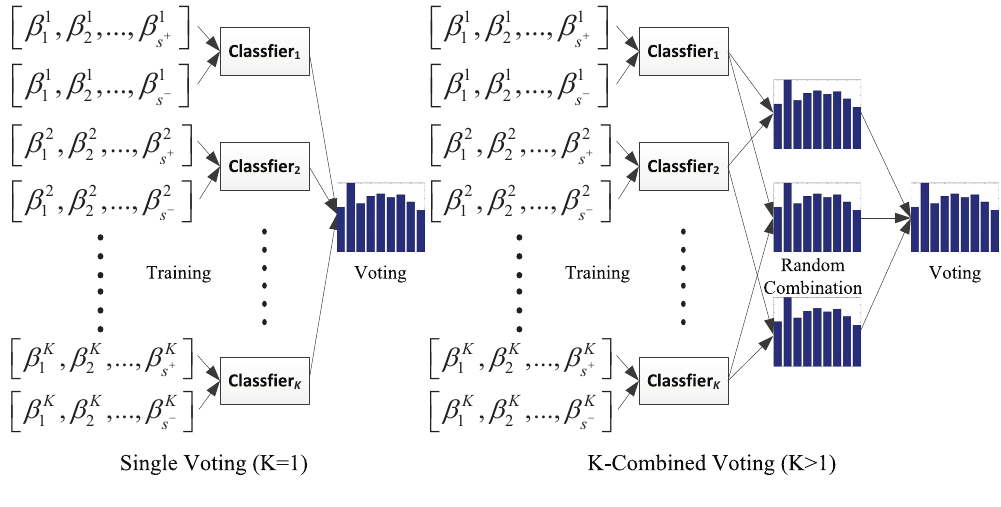
Figure 4. Single voting and random combined voting. The former scheme is a special case of the latter one with K = 1